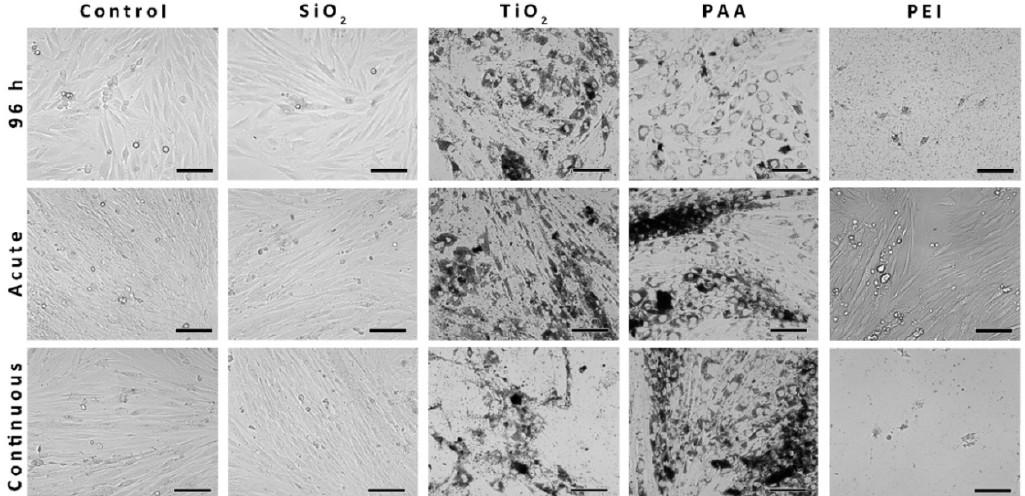
Figure 4. The morphology of the L6 cells treated with NPs and analyzed with phase-contrast microscopy. Cells were incubated with SiO 2 , TiO 2 , PAA (50 μ g/mL), or PEI (10 μ g/mL for 96 h experiment or 2 μ g/mL for 10-day experiment) NPs either for 96 h or 10 days (acute and continuous exposure protocol). Scale bars correspond to 100 μ m.